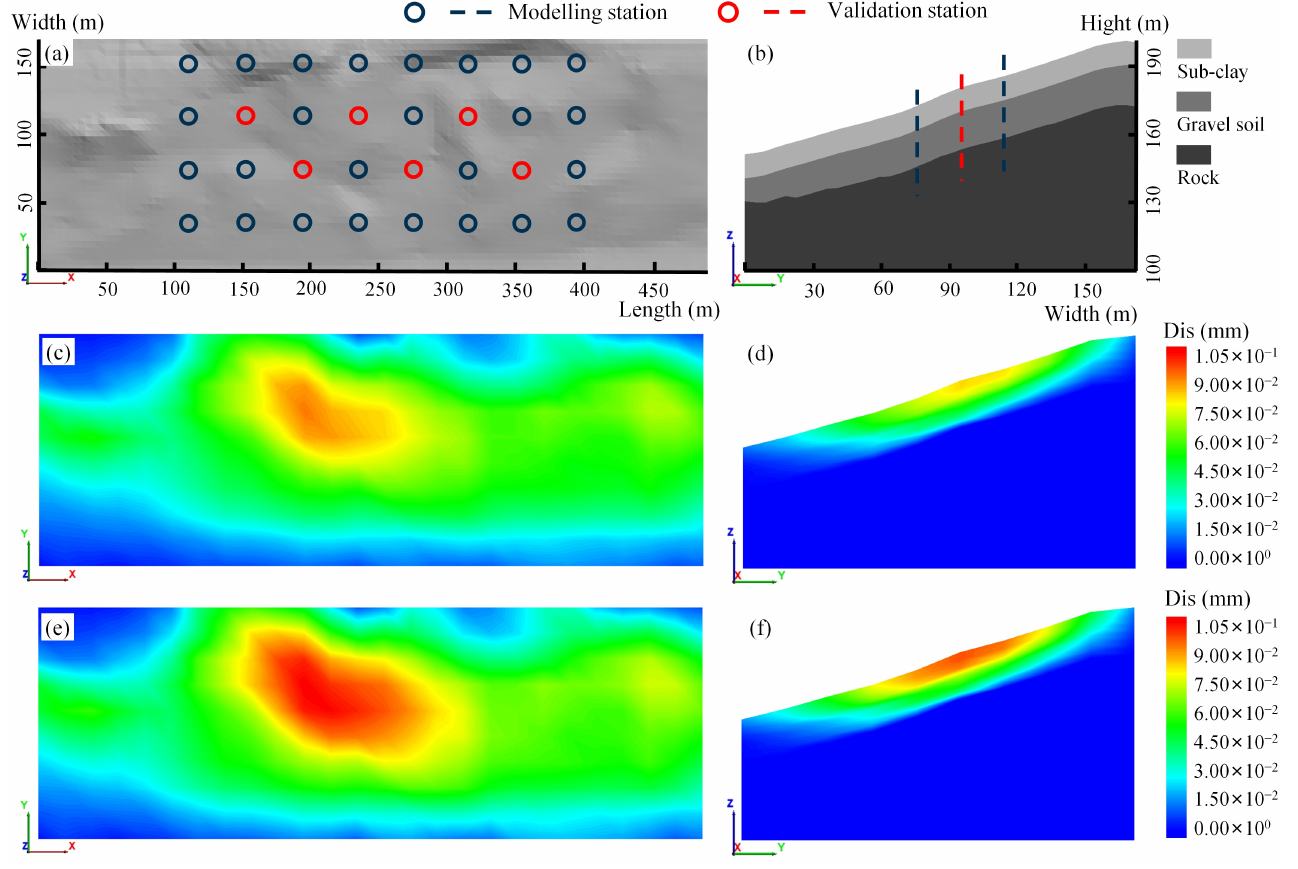
Figure 7. Simulation datasets for the slope: ( a , b ) the setting of ground and underground displacement monitoring stations; the simulation results for the surface and profile, respectively, corresponding to ( c , d ) situation 1 and ( e , f ) situation 2. The length, width, and height in ( a , b ) correspond to the dimensions of the numerical model. ( c – f ) share the same colour bar. Table 3. Parameter settings for different situations.